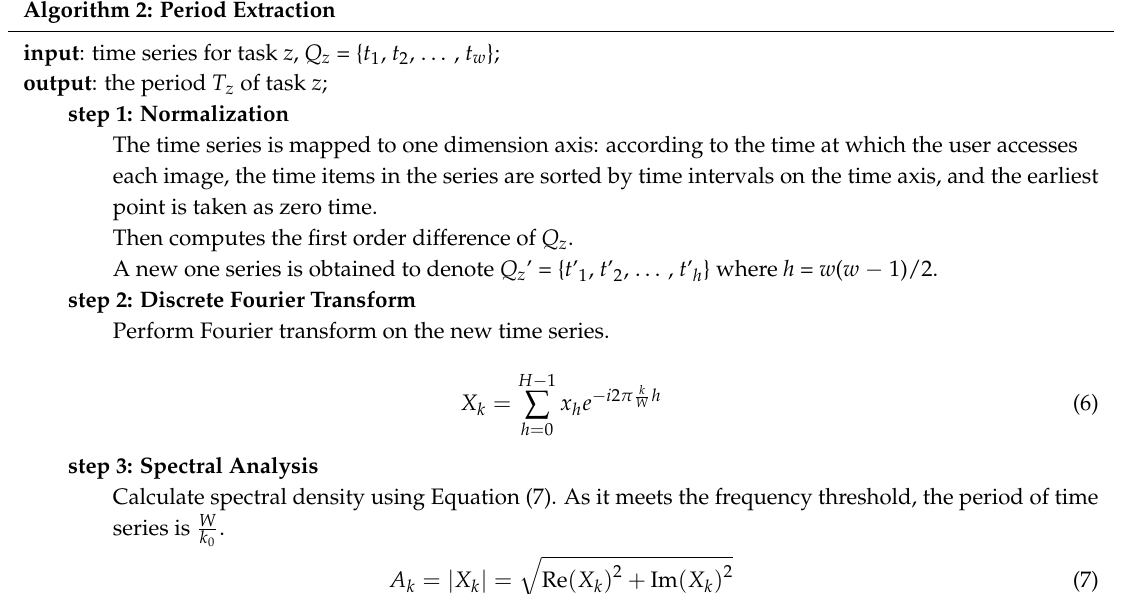
Algorithm 2: Period